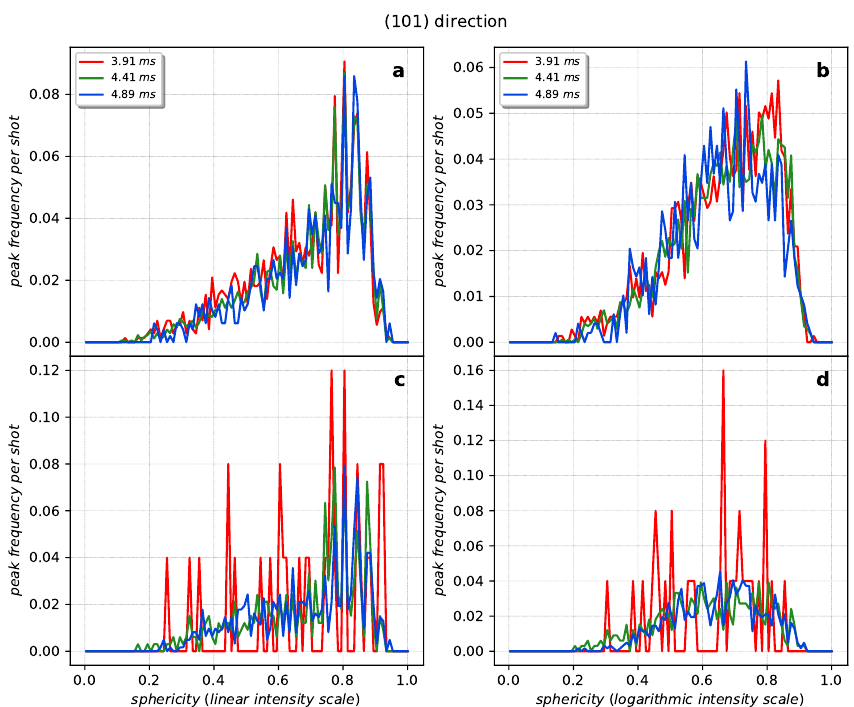
Figure A5. Frequency of a peak appearing with a certain sphericity for the (101) direction for the hits above 50 ADU/pixel ( a ) in linear and ( b ) in logarithmic intensity scales as well as the hits below 50 ADU/pixel ( c ) in linear and ( d ) in logarithmic intensity scales.